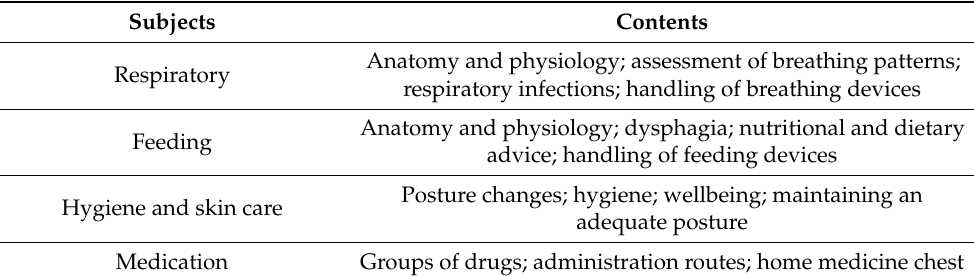
Table 1. Thematic